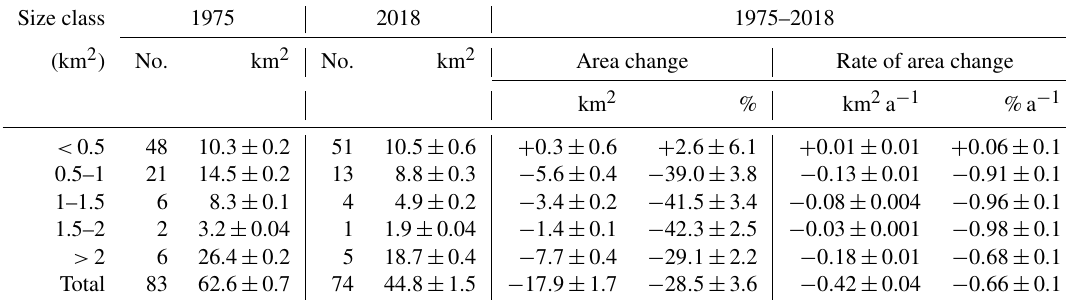
Figure 10. Glacier surface areal change in the Chhombo Chhu Watershed: (a) total glacier area change (dashed grey line is exponential best-fit relationship with associated equation and R 2 value). Error bars are the uncertainty (%) of respective years estimated using Eq. (1); (b) scatter plot of glacier area of 1975 and 2018. Red bullets in the graph indicate the 10 extinct glaciers during the phase of 1975–2018; (c) glacier change 1975–2018 for the study region. The base map is the hill-shaded relief map of the SRTM DEM. Table 5. Glacier area changes as per size class (1975–2018) in the